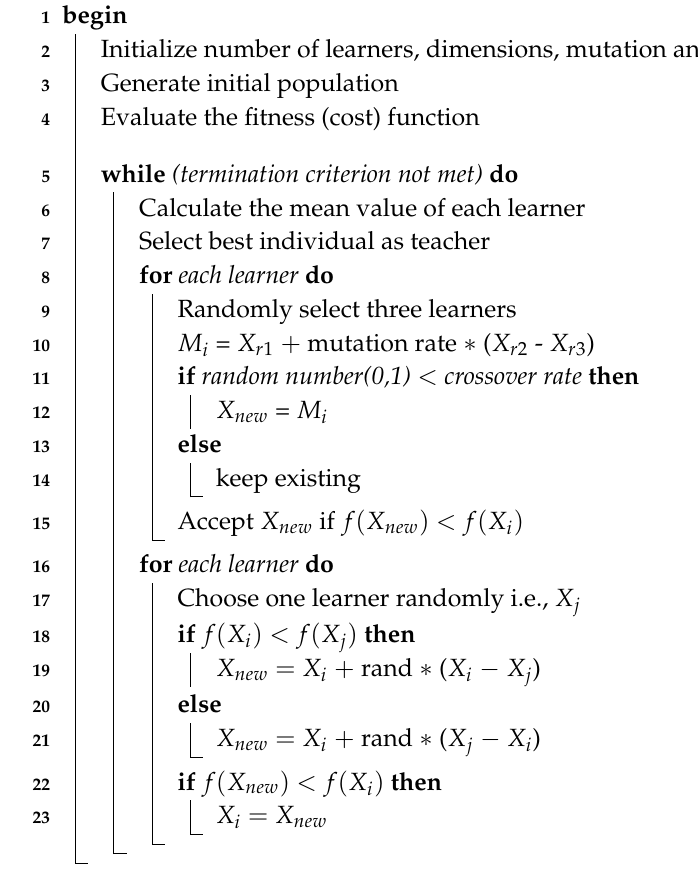
Algorithm 1: Enhanced differential teaching learning